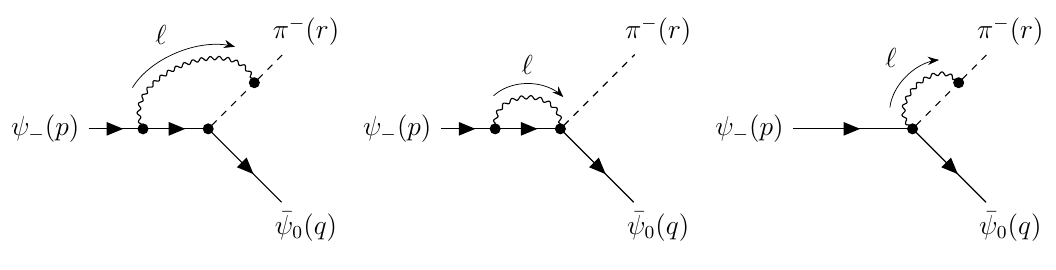
Figure 14 . The virtual QED correction to the Wino